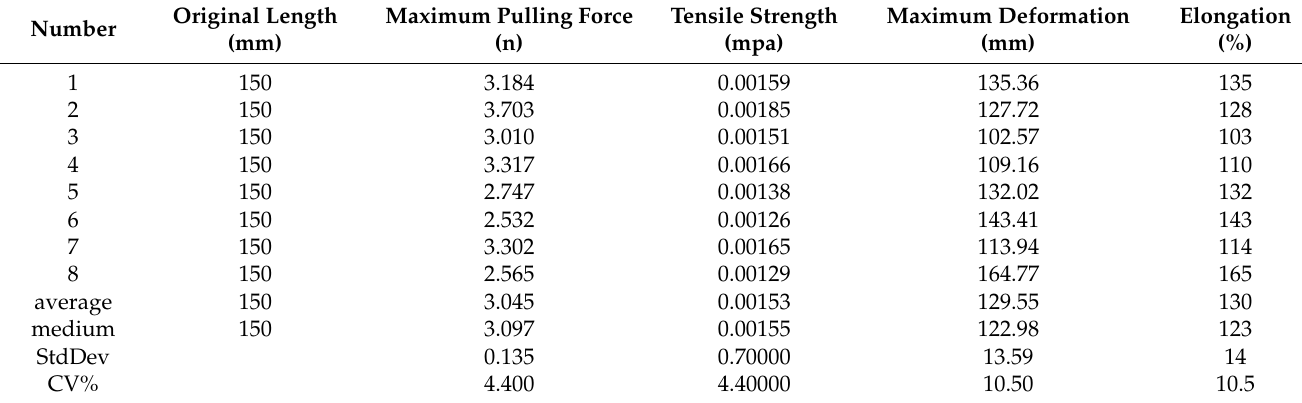
Table 1. The results of the tensile properties of plastic film.